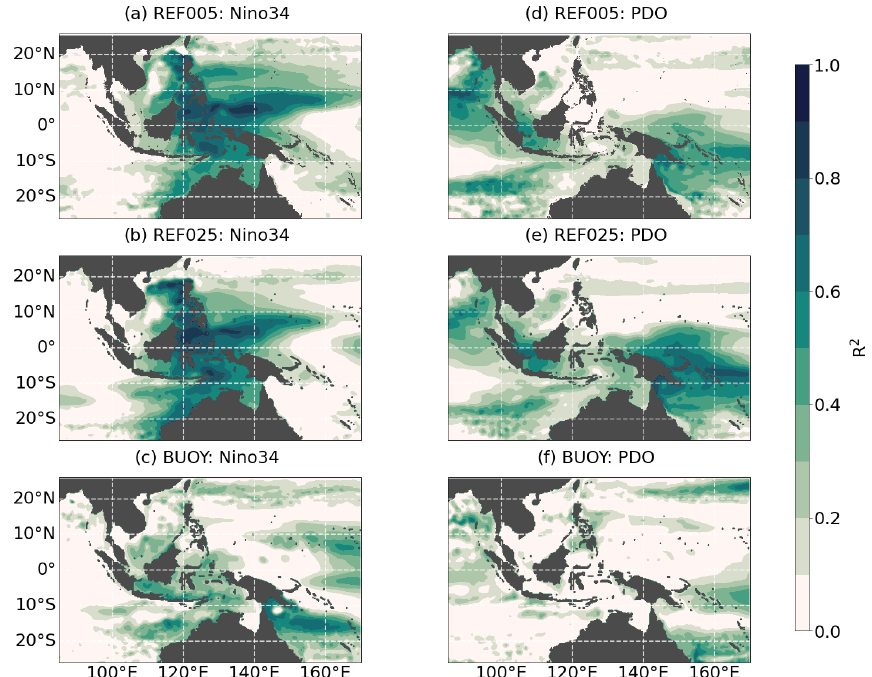
Figure 6. Coefficient of determination for the linear regression of SSH with the (a–c) Niño3.4 index and (d–f) PDO index for two hindcast (REF025, REF005) and buoyancy forcing experiments (BUOY). Climate indices are derived from the base model in the case of REF005 and from REF025 for the other two experiments. All data have been filtered with an 8-year low-pass filter.